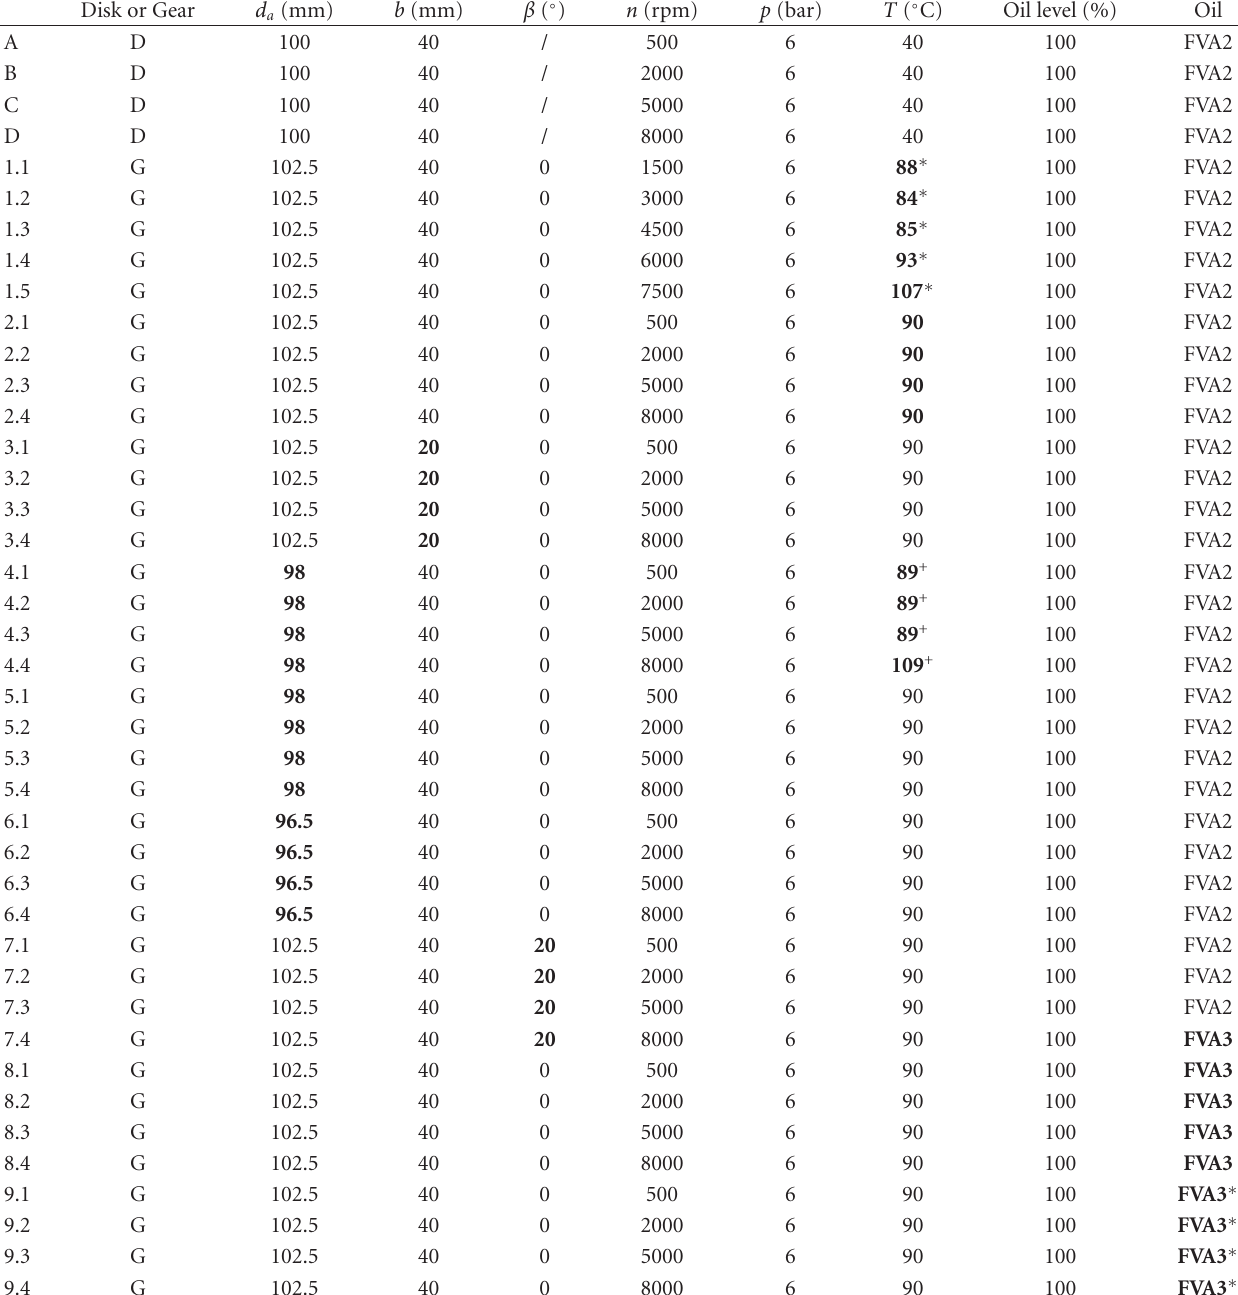
Table 4: combination of parameters adopted in the di ff erent